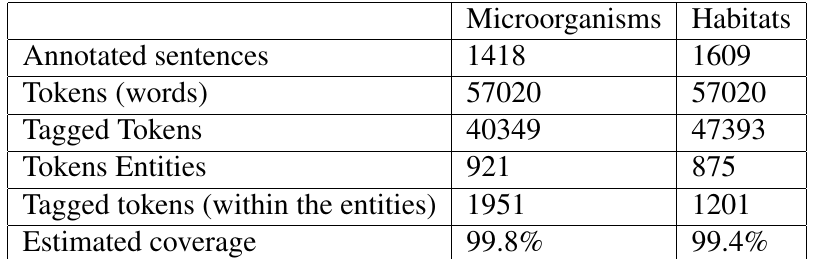
Table 1: Corpus statistics for Newcastle Organism-Habitat data